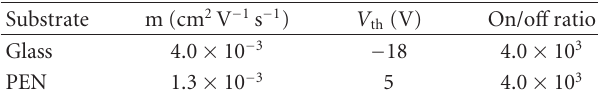
Table 3: Device performance (mobility, on/o ff ratio, and V th ) of P3HT TFT on glass and PEN substrate with PMSQ as the gate insulating layers.